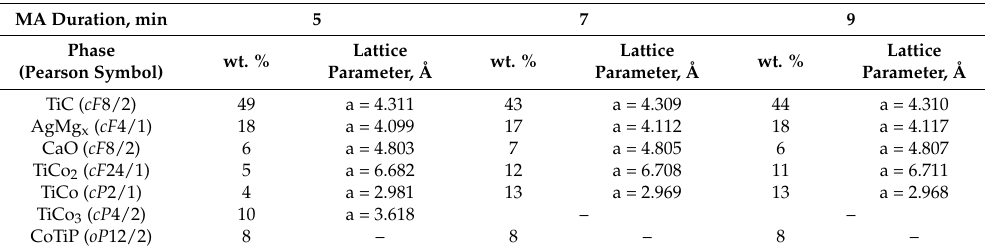
Table 2. Composition of the synthesis products after the combustion of the Ti–C–Co–Ca 3 (PO 4 ) 2 –Ag–Mg mixtures at X = 24% in BKS after the MA for 5, 7, and 9 min.